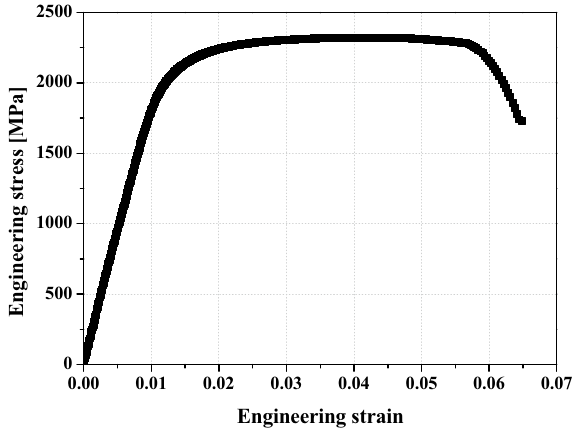
Figure 1. Engineering stress–strain curve of OT wire.